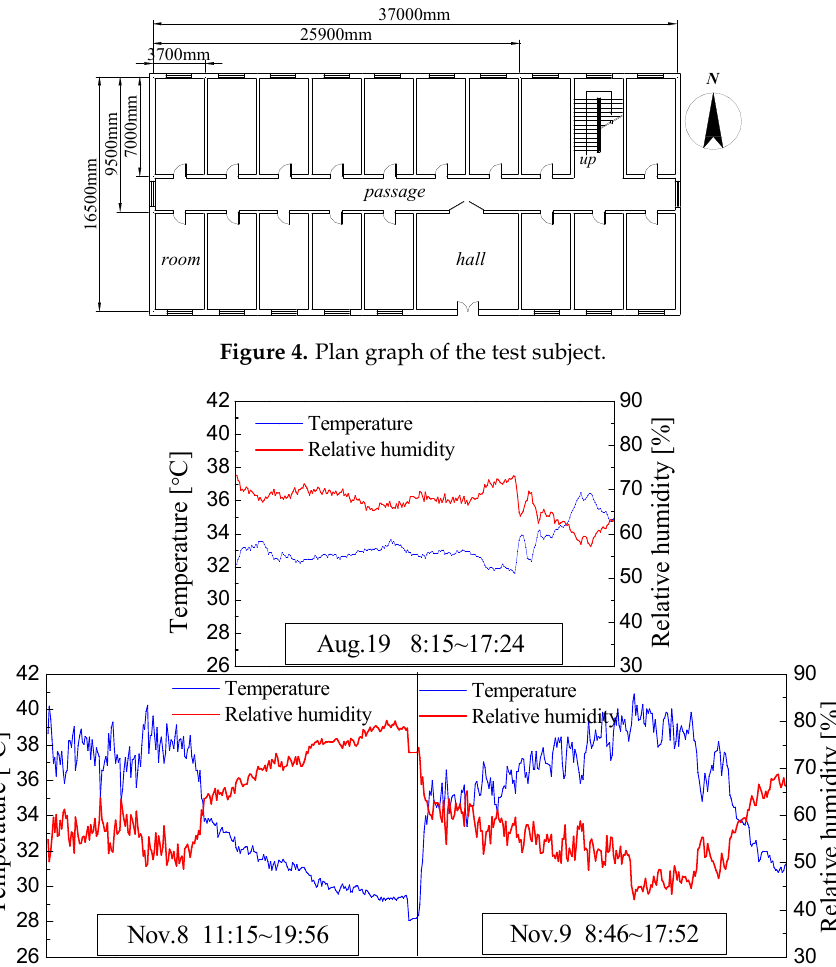
Figure 5. Changing diagram of air temperature and relative humidity during testing.